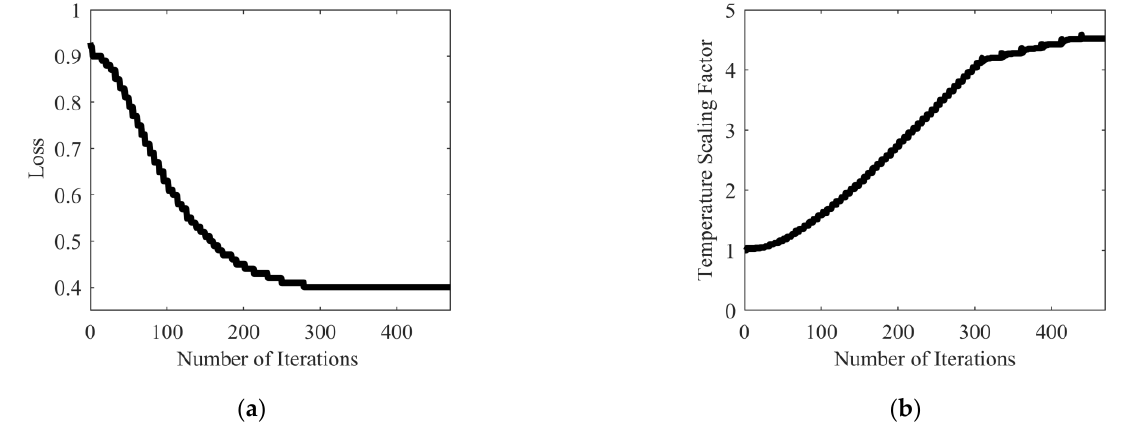
Figure 3. The learning process of the temperature scaling factor. ( a ) Loss in learning process; ( b ) The temperature scaling factor in learning process.